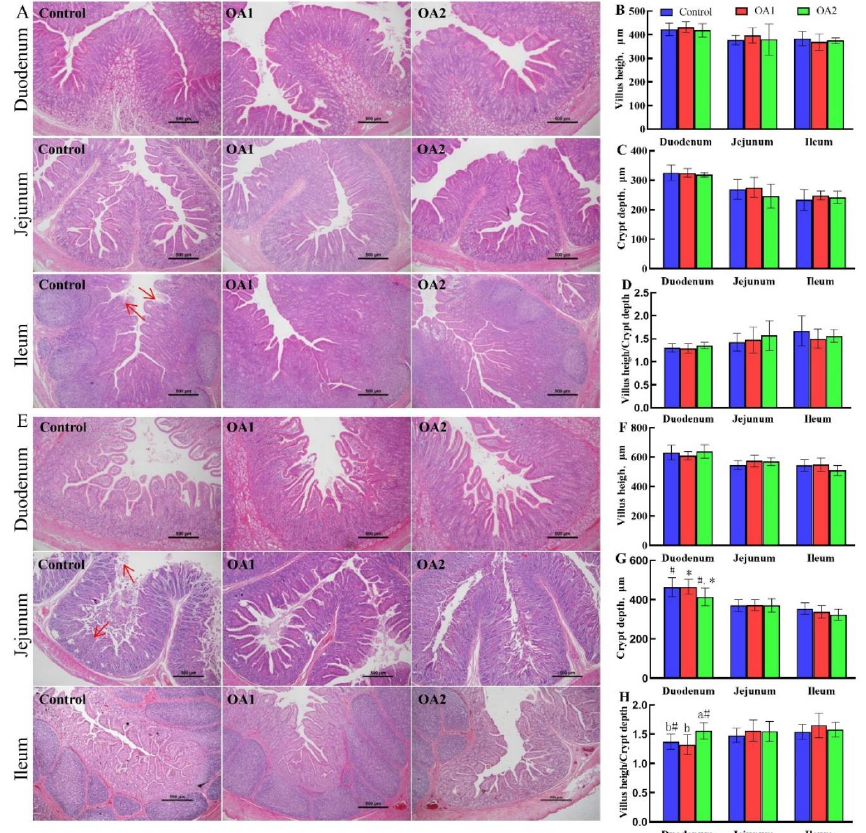
Figure 1. Effects of acidifiers on the gut morphology of the small intestine of piglets. The histopathology of the duodenum, jejunum, and ileum at day 14 ( A ) and day 49 ( E ). The morphology of villus height ( B ), crypt depth ( C ), and villus height/crypt depth ( D ) at day 14. The morphology of villus height ( G ), crypt depth ( F ), and villus height/crypt depth ( H ) at day 49. Values are means ± SD, n = 6. Labeled means in a row with different letters differ, p < 0.05. A given 2 means labeled with # indicates a tendency, 0.05 ≤ p < 0.10. At the red arrow, the intestinal villi were broken off and the intestinal epithelial cells were denatured and necrotic.